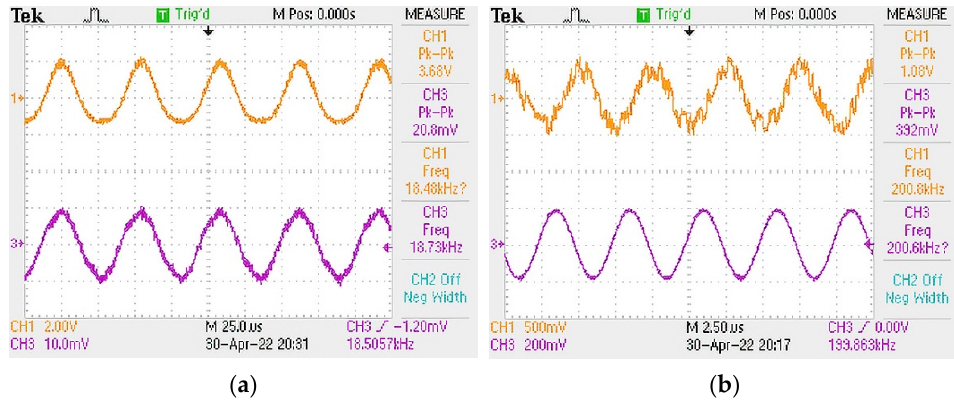
Figure 6. Ultrasound responses at ( a )18.5kHz and ( b ) 200kHz of the sensor and the commercial standard ultrasonic sensor. The yellow curve is the sensor, and the purple curve is the commercial standard ultrasonic sensor.